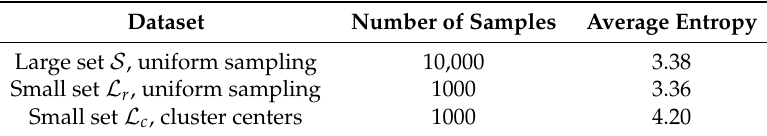
Table 1. Average per-feature entropy in a training data